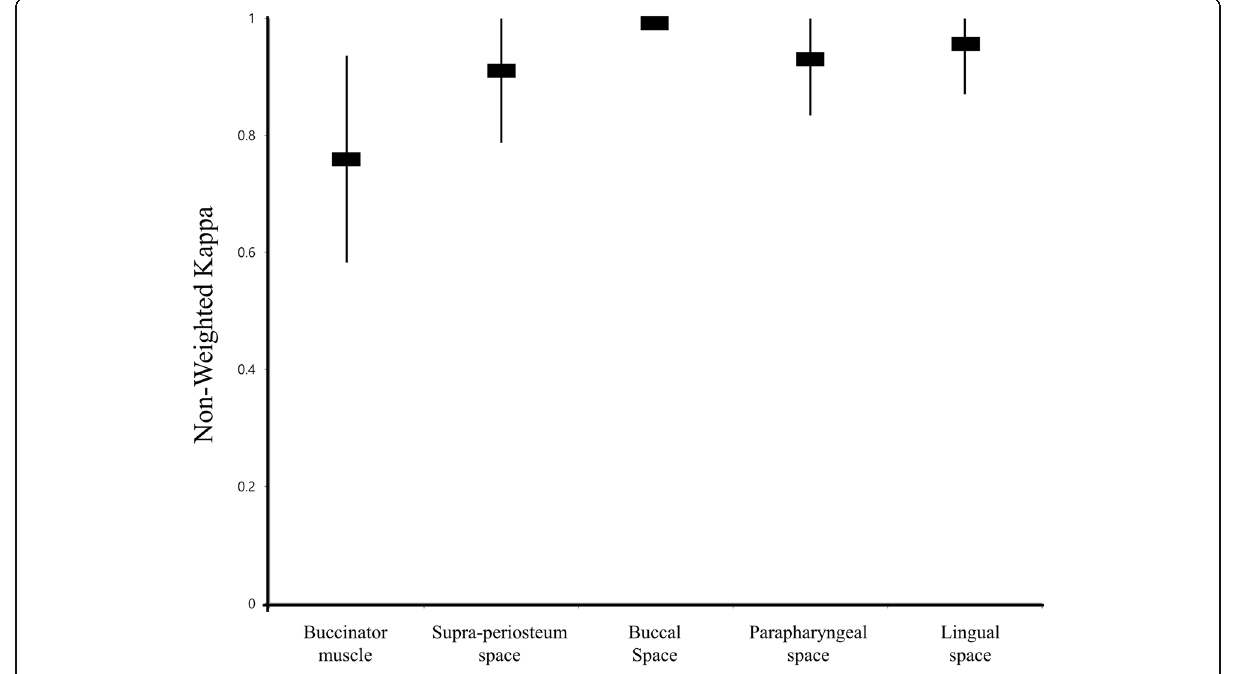
Fig. 3 Kappa agreement between the two examiners for each postoperative edema